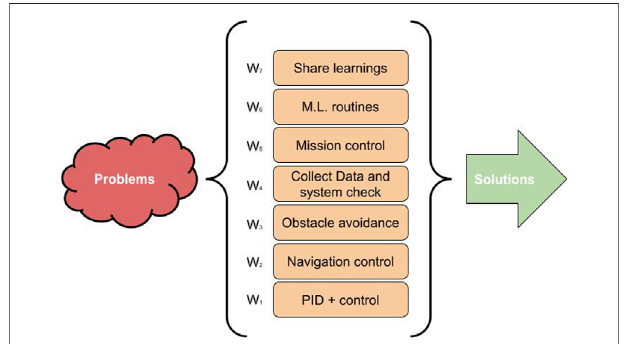
FIGURE 2 | Basic architecture of N-Boat and F-Boat inspired in the subsumption architecture.